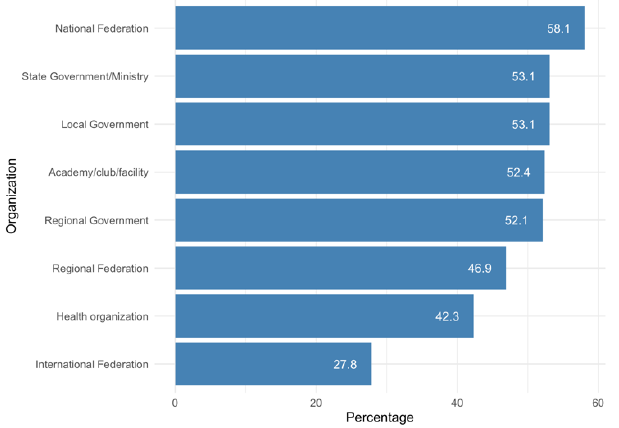
Figure 2. Sources of information consulted by coaches.